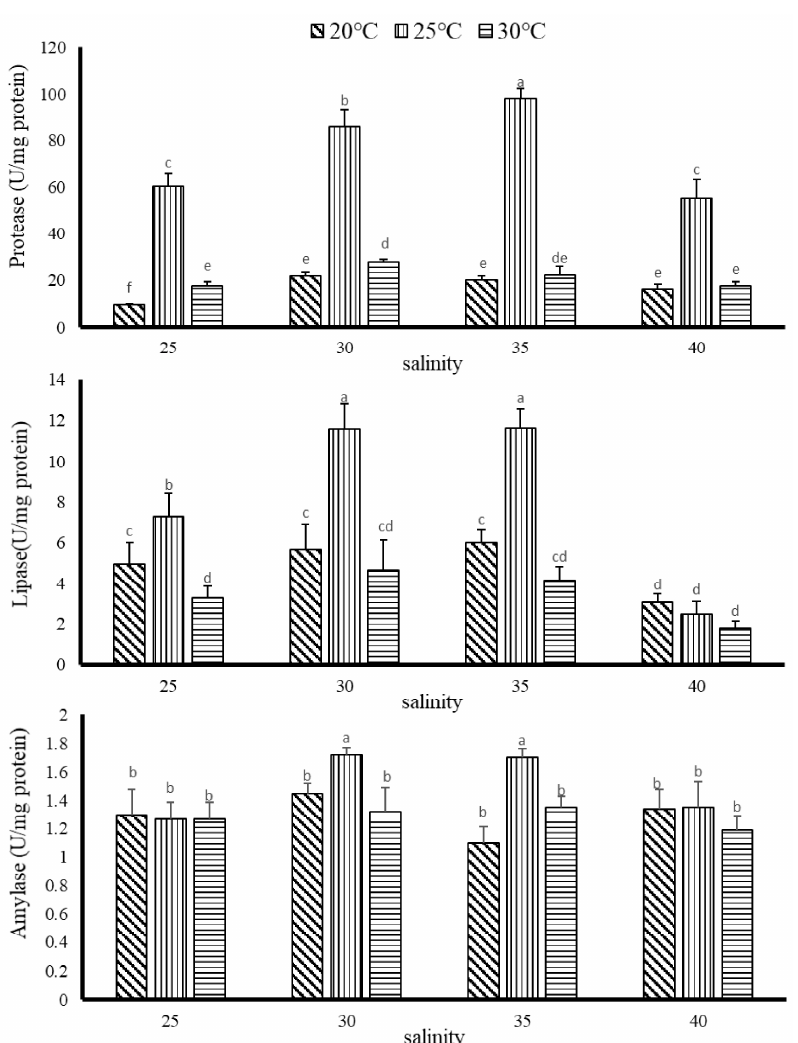
Figure 5. The activity of digestive enzymes in G. columna coral after 8 weeks of feeding at different temperatures and salinities. Each value represents ±SD ( n = 3). The Latin alphabet represents signif- temperatures and salinities. Each value represents ± SD ( n = 3). The Latin alphabet represents icant differences (p < 0.05). significant differences (p <